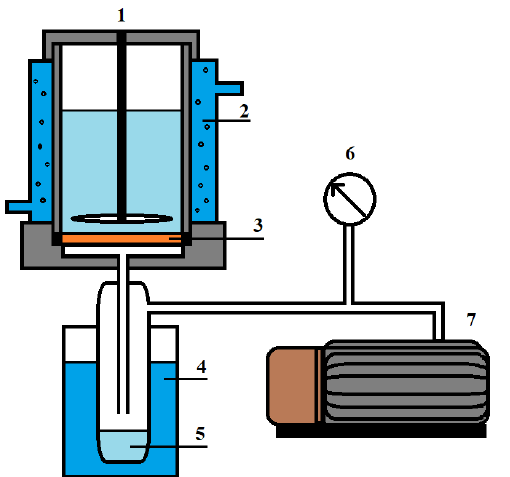
Figure 3. Pervaporation setup: 1—pervaporation cell, 2—temperature controller, 3—membrane, 4—trap cooled by liquid nitrogen, 5—permeate; 6—manometer and 7—vacuum pump using to control the pressure.